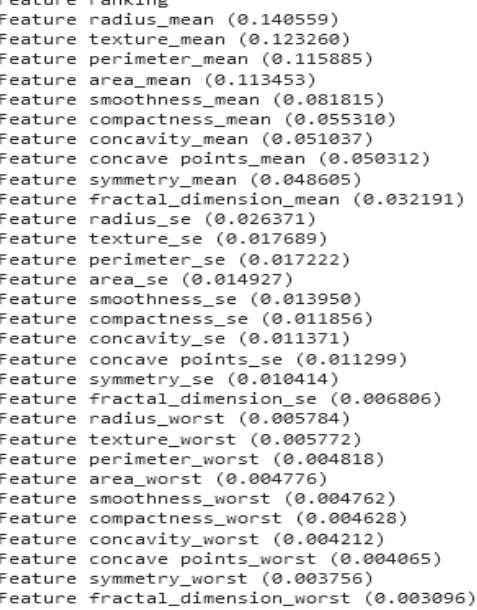
Figure 4. Statistics of the missing values of the datasets features.